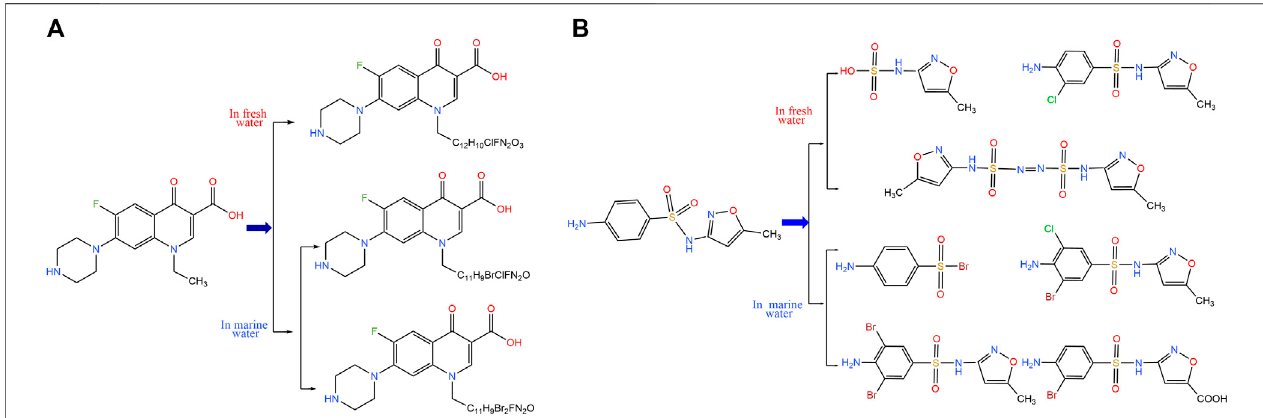
FIGURE 5 | Conversion of antibiotics to disinfection byproducts. End products of Nor fl oxacin or Sulfamethoxazole (McInnes et al.) reacts with NaClO in different water environments.